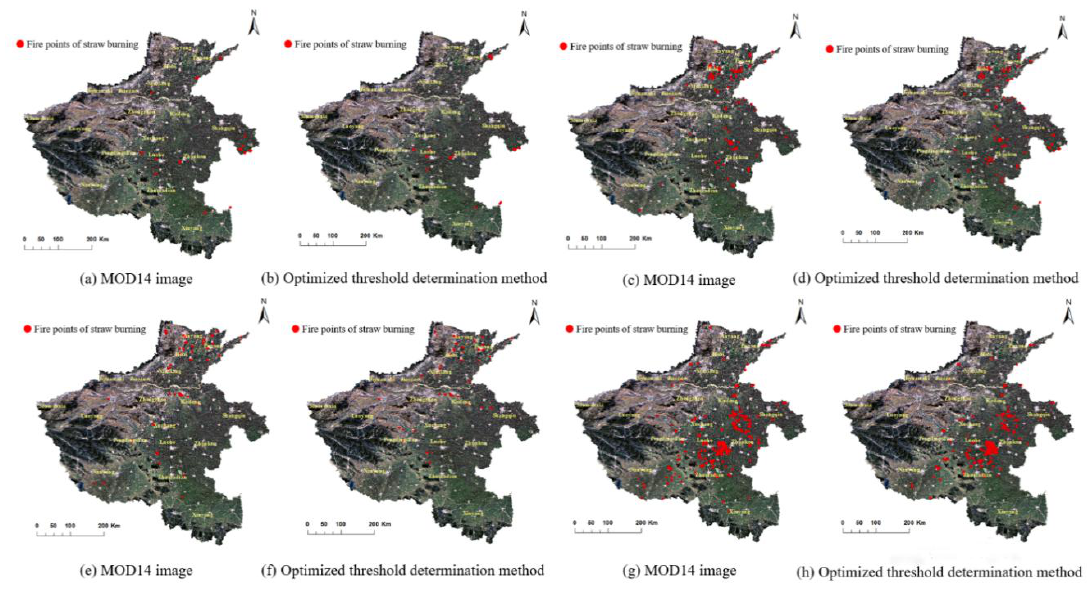
Figure 6 . Distribution comparison of fire points of straw burning on June11,2014: (a), (b); October 7, 2014: (c), (d); June 9, 2015: (e), (f); and October 1, 2015: (g),